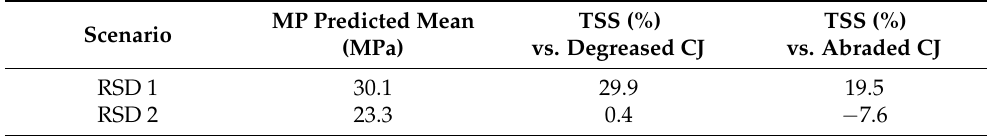
Table 15. Comparison of TSS values (MP Predicted